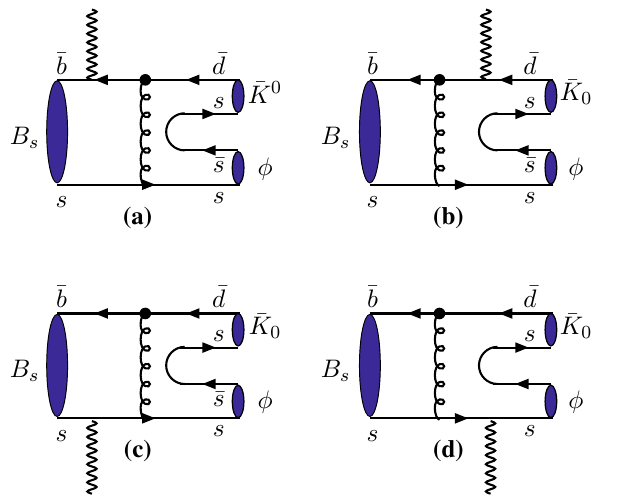
Fig. 2 Feynman diagrams of chromomagnetic penguin operator O 8 g . A hard gluon is emitted through the O 8 g operator, and a photon is emitted by bremsstrahlung of external quark lines